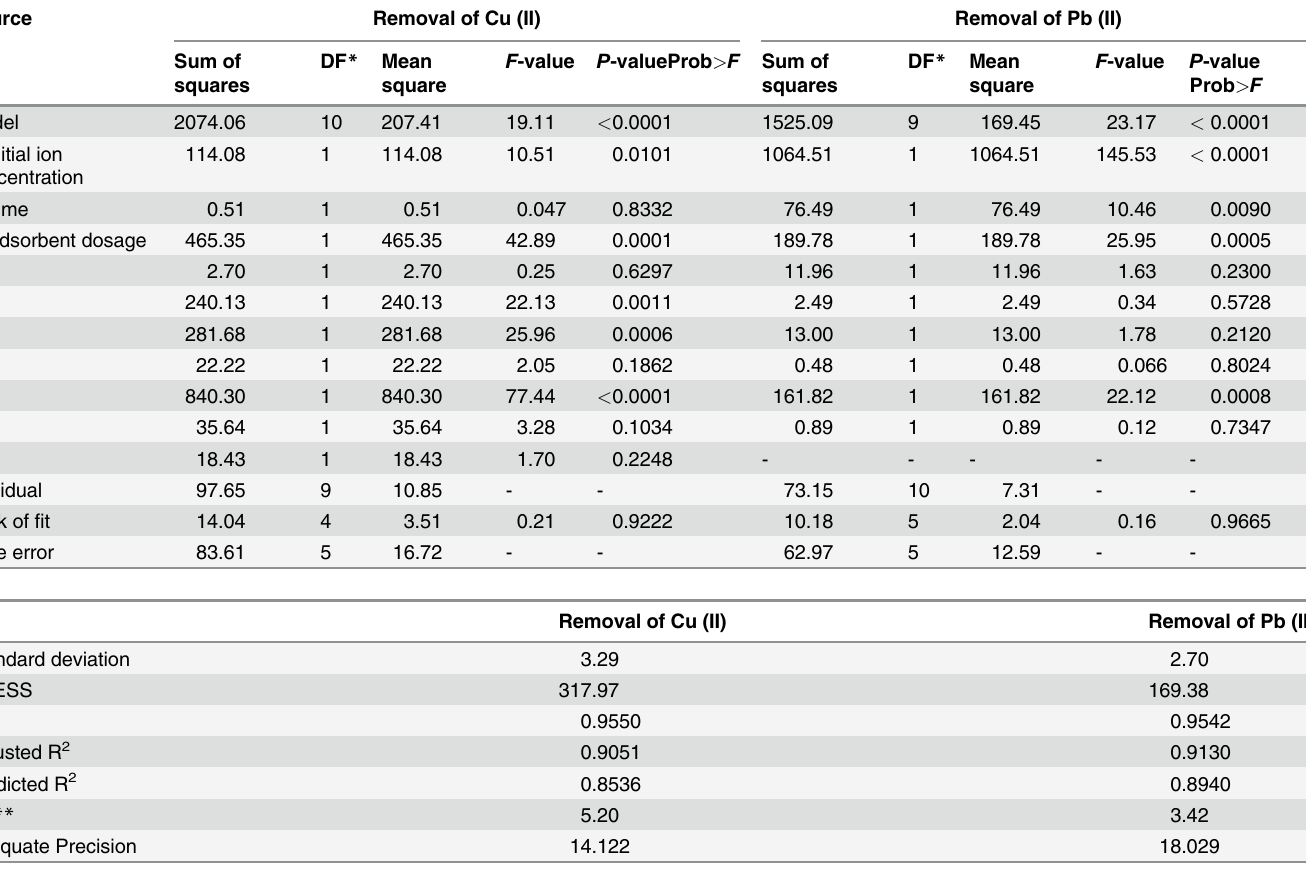
Table 3. Analysis of variance of the fitted quadratic equation for removal of Cu(II) and Pb(II), by nano-adsorbent and regression coefficients of the final reduced models.